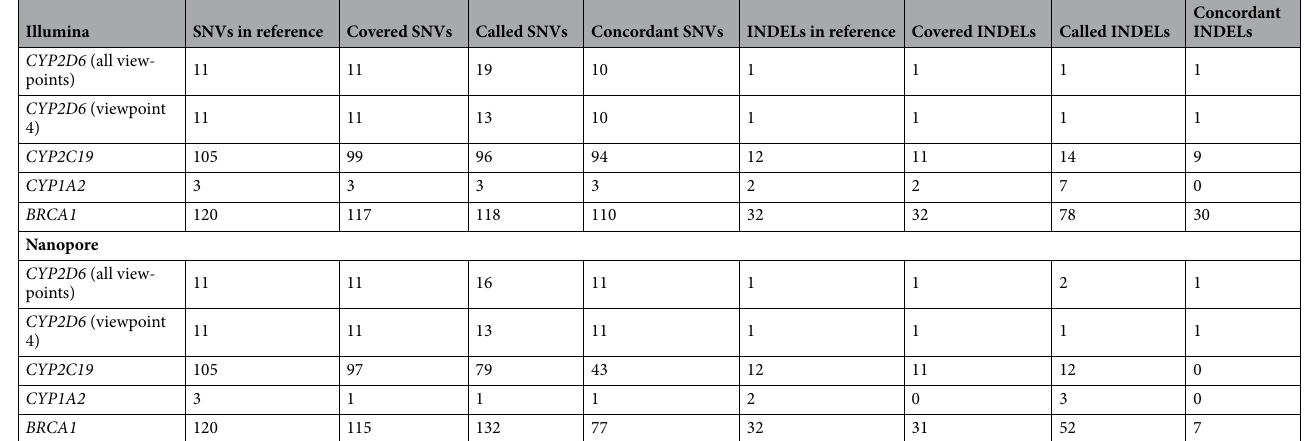
Table 4. Overview of the variants in the reference of Krusche et al. 23 and the called variants in the Illumina and Nanopore datasets for each studied gene. The upper part shows the number of variants called in the Illumina datasets, while the lower part shows the number of variants in the Nanopore datasets. Covered SNVs and INDELs are the variants where the sequencing depth was at least 25X and 100X for Illumina and Nanopore datasets, respectively.